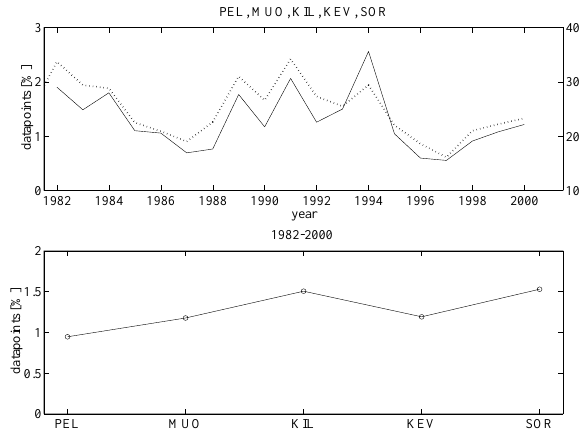
Fig. 3. Relative number of datapoints used in Fig. 2. Upper panel: yearly average of all five stations; the dotted line is the yearly aver- age of the aa index (obtained from the National Geophysical Data Center). Lower panel: average value at stations from 1982 to 2000. The sampling interval used here is 20 s, which was the original one for data from 1982 to 1992. The newer 10 s data were averaged to 20 s values